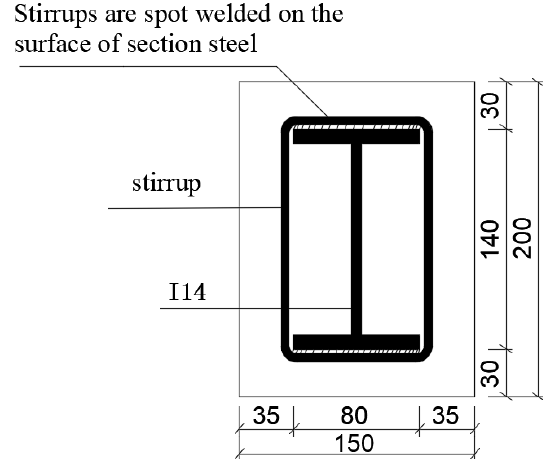
Figure 3. Uniaxial tensile stress-strain curve.